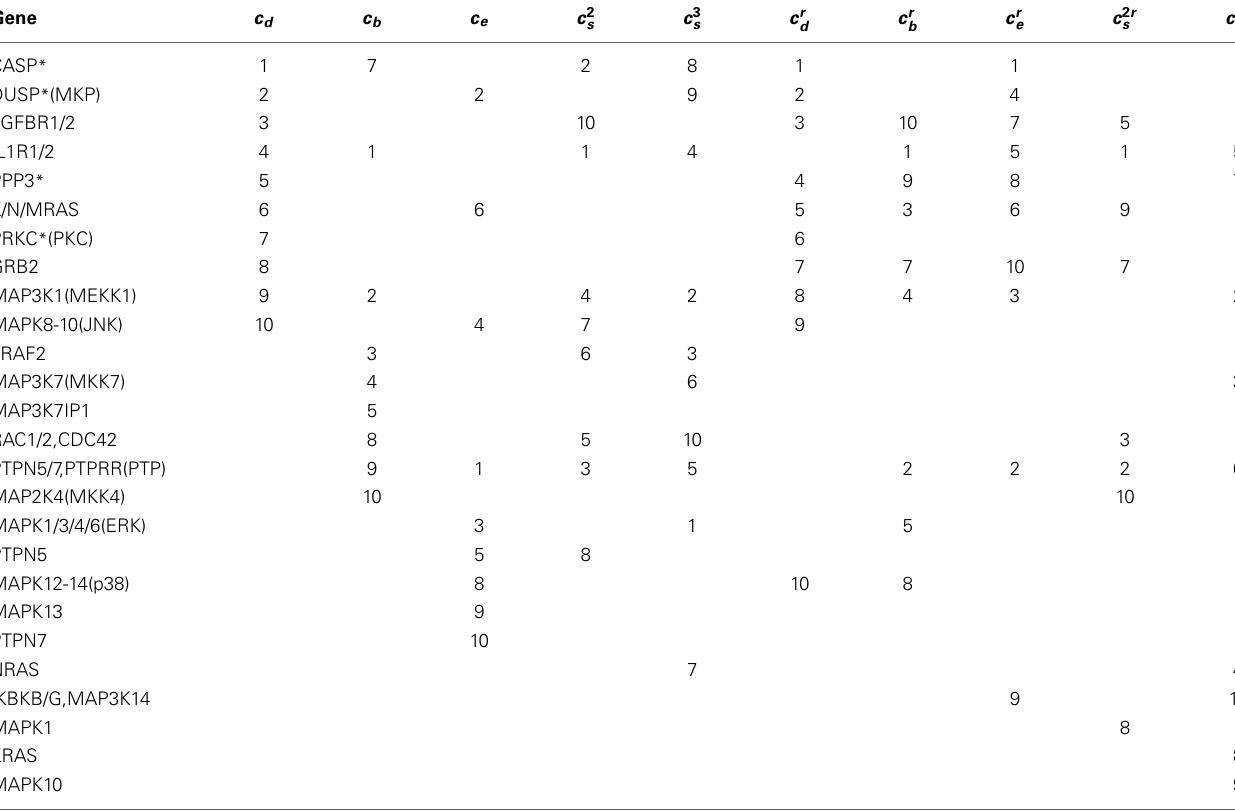
Table 4 | Top ranking genes in MAPK pathway (WikiPathways) by various centrality measures. Gene